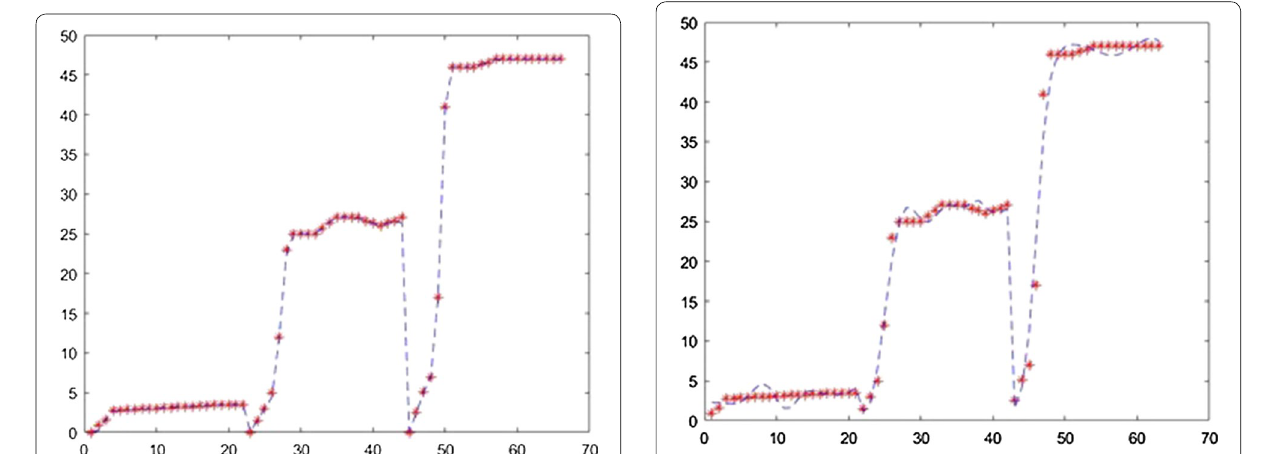
Fig. 10 Model results obtained with the Fletcher–Powell Conjugate Gradient